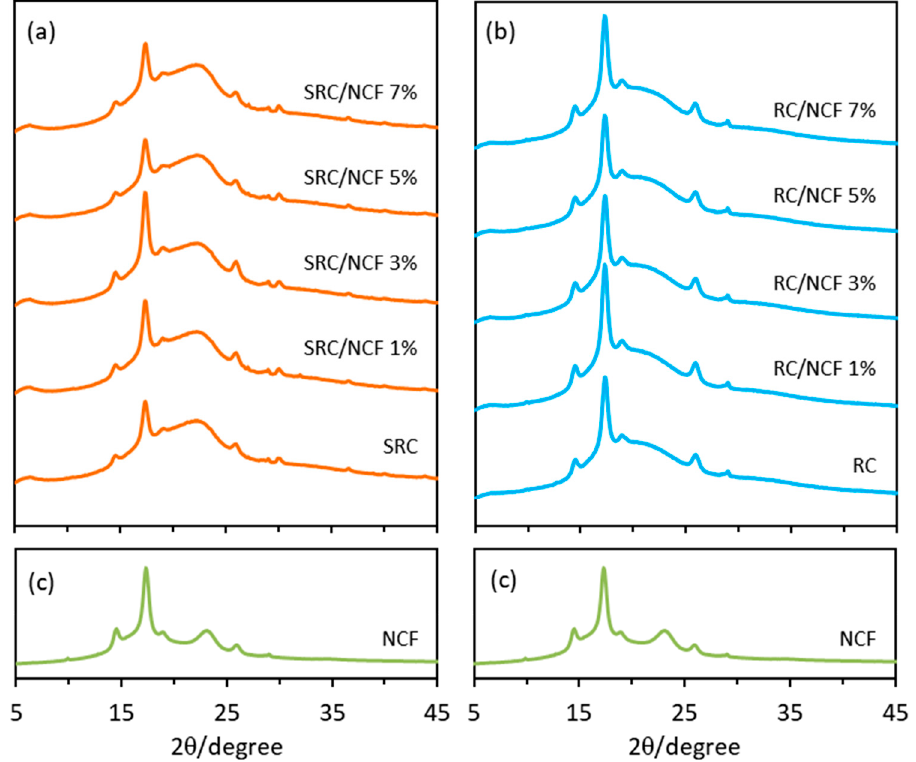
Figure 8. X-ray di ff raction spectra of the ( a ) SRC / NCF films, ( b ) RC / NCF films, and ( c ) Figure 8. X-ray diffraction spectra of the ( a ) SRC/NCF films, ( b ) RC/NCF films, and ( c ) NCF. The diffraction spectra were recorded using Cu K α radiation ( λ = 0.154 nm) at 40 kV and 20 mA.